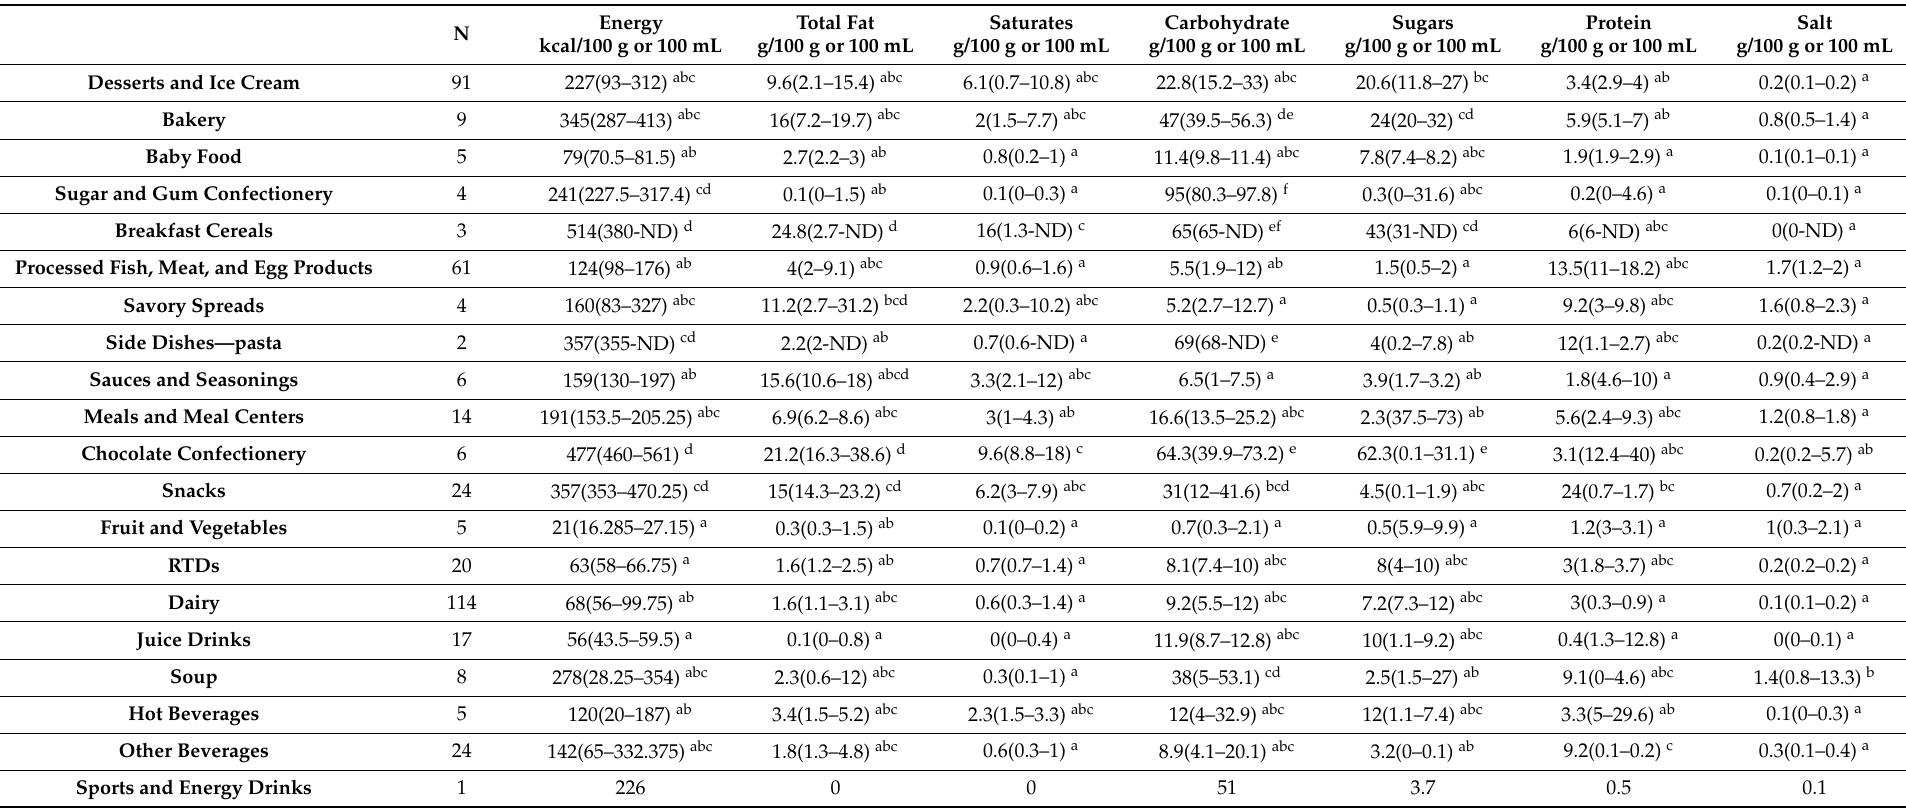
Table 2. Nutritional composition of food and beverages launched in the Spanish market in the latest 5 years containing algae and derived